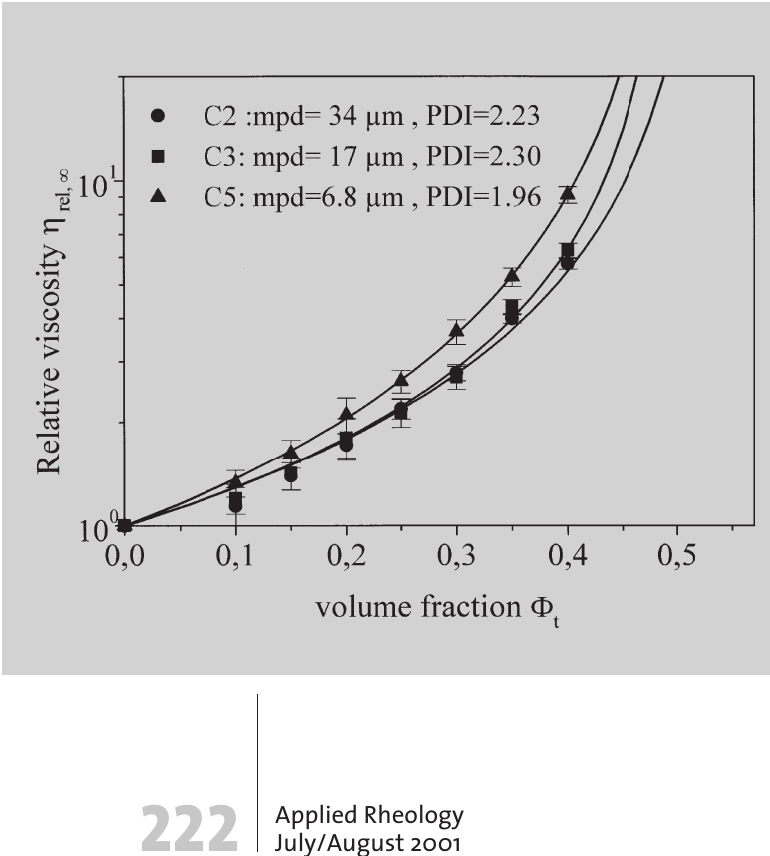
Fig. 1: Relative viscosity h rel, • as a function of F t for the polydisperse distrib- uted glass sphere samples C2,C3 and